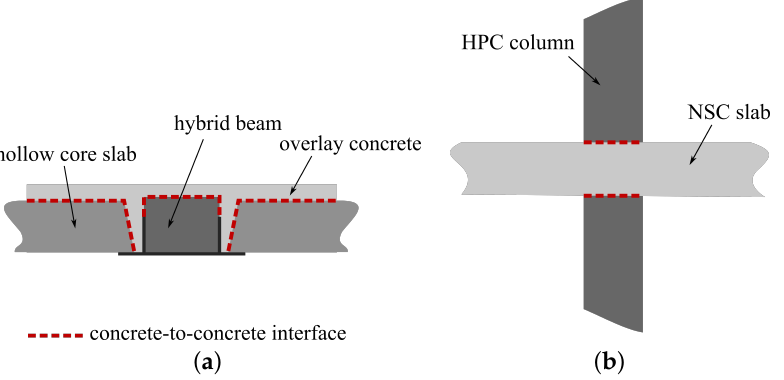
Figure 1. Examples of concrete-to-concrete interfaces in structures: ( a ) a composite floor on hybrid beams, ( b ) a slab-column